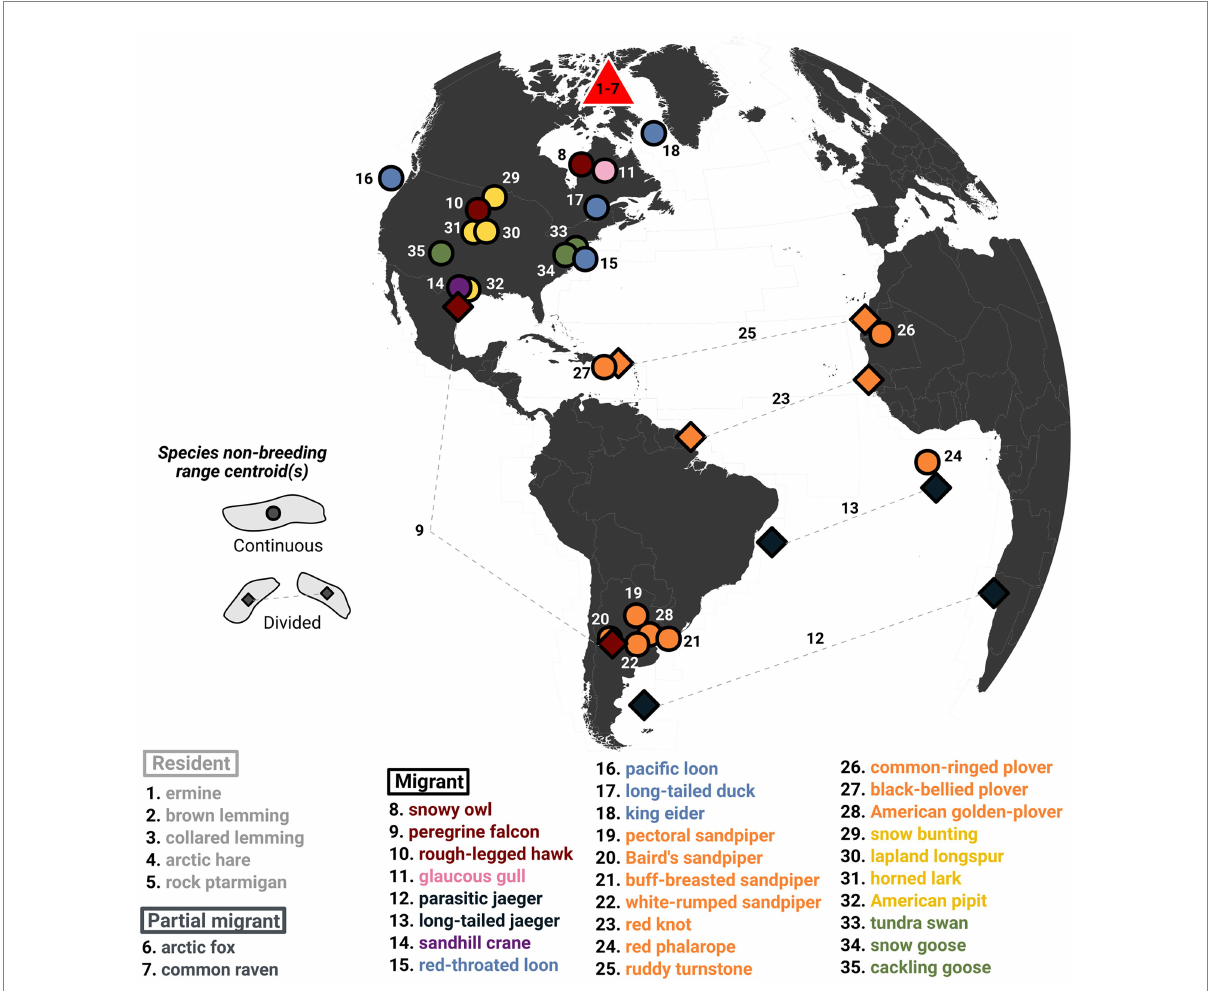
FIGURE 4 Non-breeding range centroids of vertebrate species from Bylot Island. The migratory species are colored by functional groups (red = raptors, pink = gulls, purple = cranes, dark blue = jaegers, light blue = ducks and loons, orange = shorebirds, yellow = passerines, green = geese and swans). The non-breeding centroid of residents and partial migrants are not represented since they are centered on Bylot Island. The centroids of migratory species with a continuous non-breeding range are represented by a circle, and squares are used to represent the centroids of divided non- breeding ranges (i.e., jaegers travel to both Atlantic coasts). The location of some centroids was slightly adjusted to better represent the species non-breeding habitat type, for instance, moving the centroid of a coastal species falling inland to the closest